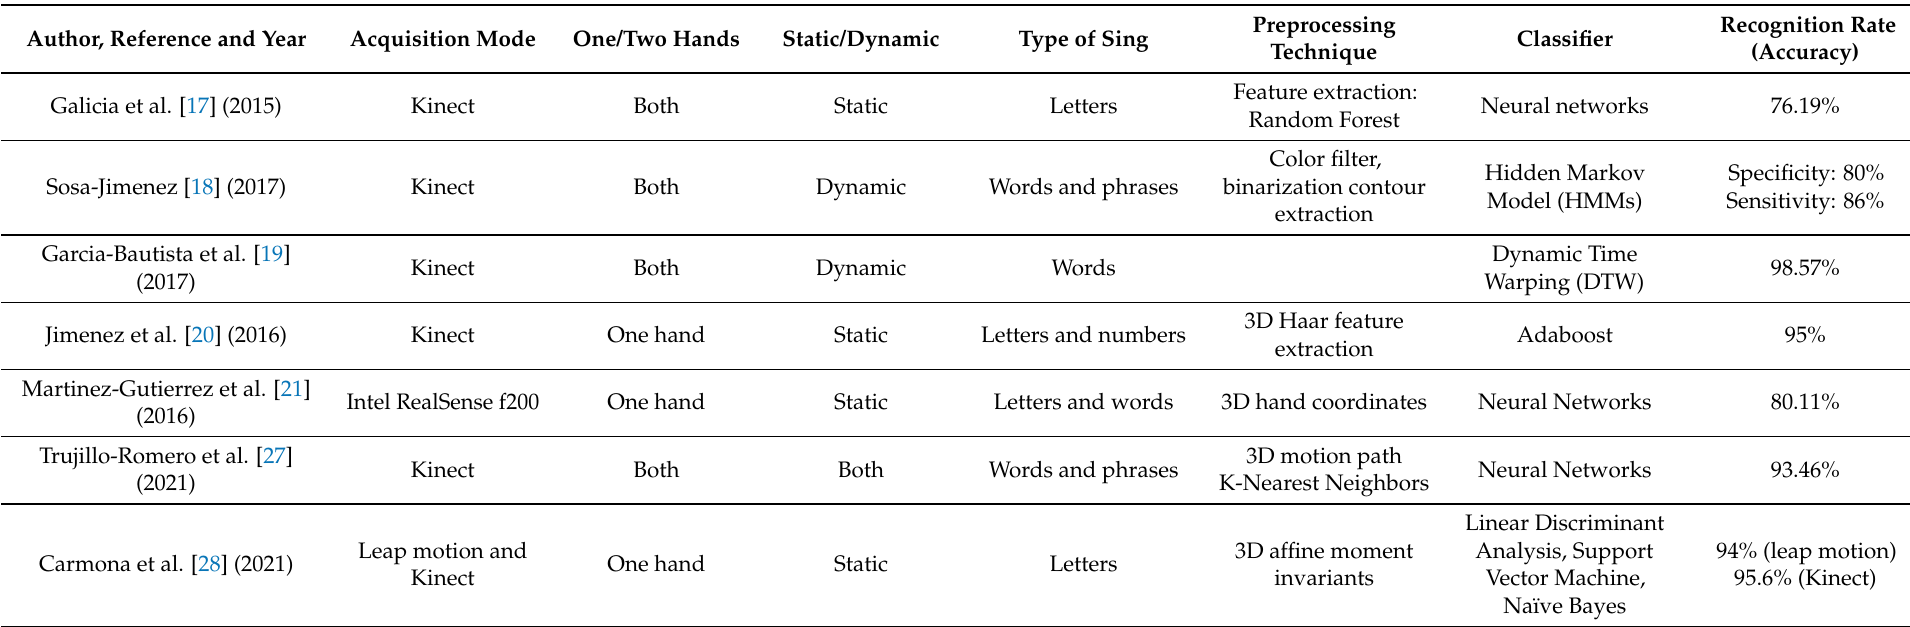
Table 1. Summary of systems using RGB-D cameras for MSL